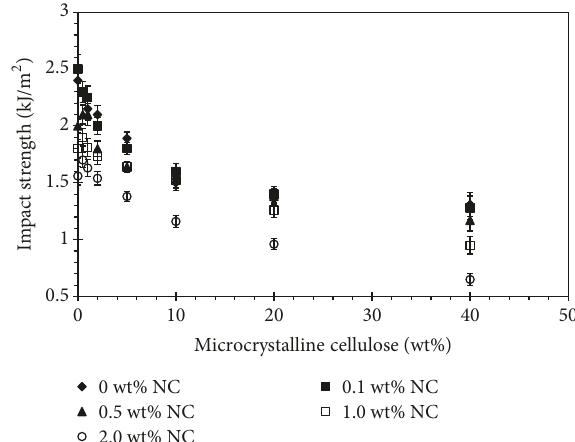
Figure 12: Yield strength PP/MCC composites as a function of NC wt%.